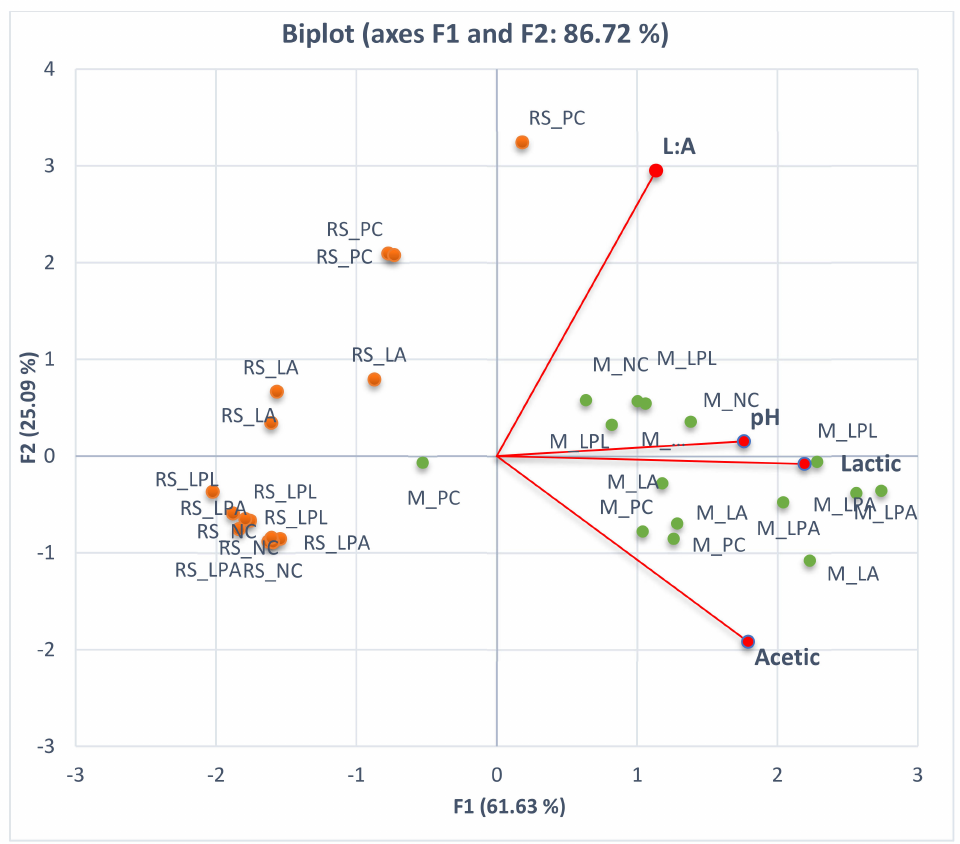
Figure 1. Principle component analysis (PCA) of fermentation products (lactic acid, acetic acid, L: A ratio, and pH) in 40 days ensiled maize and rice straw silage. M: maize silage; RS: rice straw, NC: negative control; PC: positive control; LPA: Lactobacillus paracasei , LPL: Lactobacillus plantarum; LA: L.